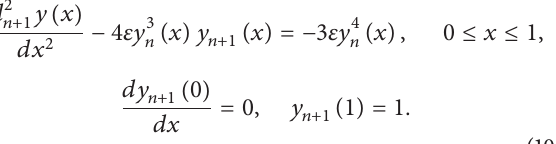
Figure 1: Solutions by Haar wavelet-quasilinearization technique for different 𝜀 at 𝐽 = 5 and 𝑛 = 4